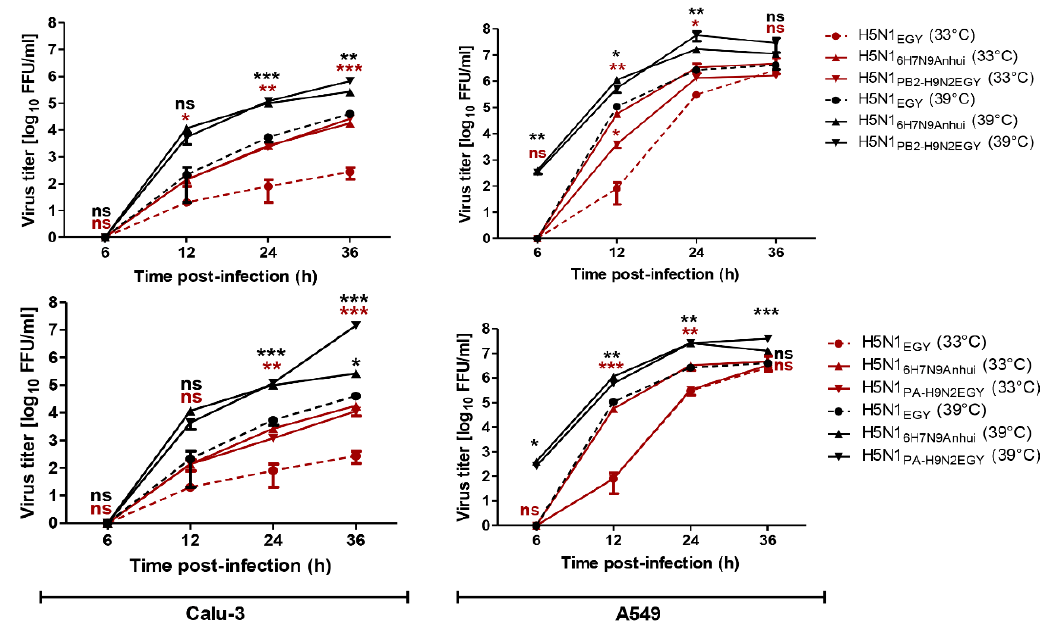
Figure 4. Replication kinetics of H5N1 EGY reassortants in mammalian cell culture models. Calu-3 and A549 cells were infected (in triplicates) with the H5N1 EGY reassortants or wild-type H5N1 EGY and control H5N1 6H7N9Anhui at multiplicities of infection (MOIs) of 0.001 and incubated at 33 ◦ C or 39 ◦ C. At 6, 12, 24, 36 h p.i., the cell culture supernatants were collected and the virus titre was determined. Statistical analysis was performed using two-way ANOVA, followed by Bonferroni post hoc test. The significant di ff erences are indicated (* = p < 0.05, ** = p < 0.01, *** = p < 0.001 and non-significant = ns).